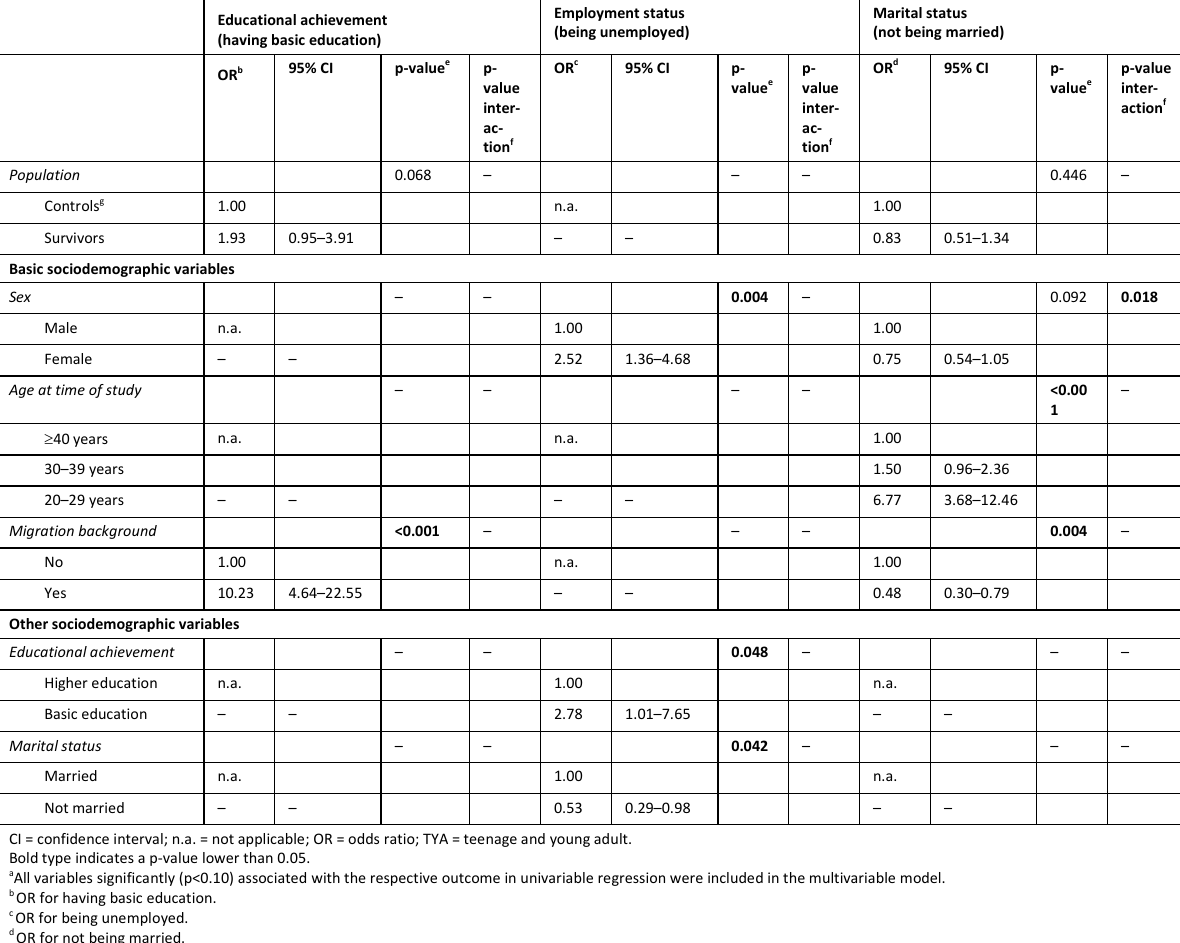
Table 3: Factors associated with educational achievement, employment status and marital status from multivariable logistic regression models a (combined dataset including TYA cancer survivors and controls). Educational achievement (having basic education)